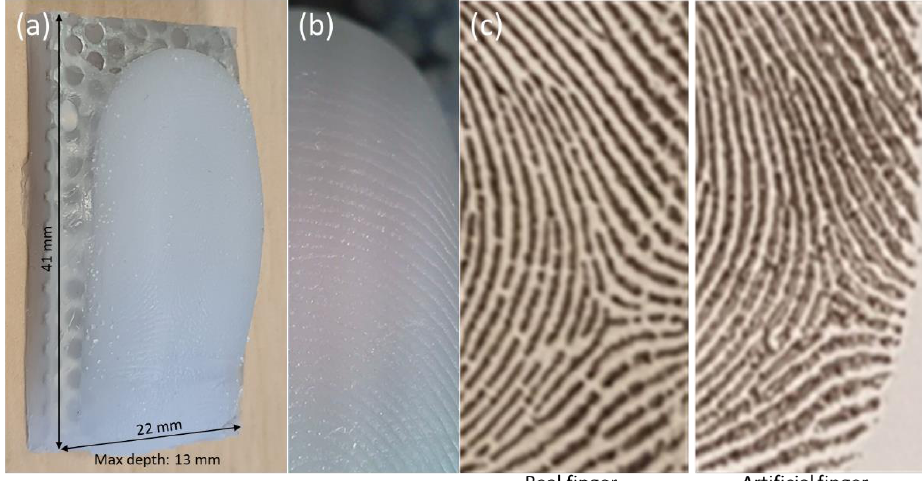
Figure 3. Topological quality of artificial finger-pad. ( a ) Entire artificial finger-pad, ( b ) magnified view of portion showing topology ( × 20), and ( c ) comparative ink prints from same region of real finger and artificial finger from human subject. Note only portion of entire print is shown for data protection purposes.